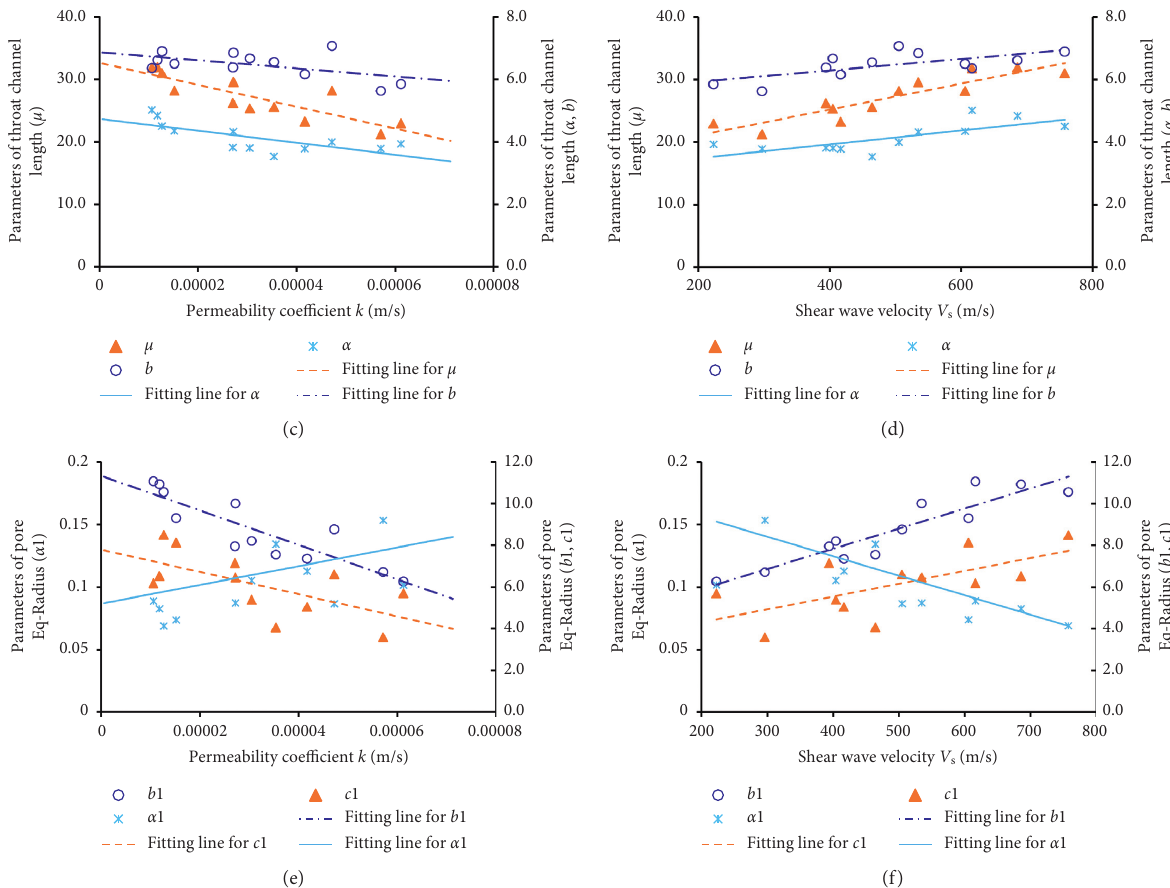
Figure 12: The relationships between the physical properties and the fitting function parameters of the loess: (a) permeability coefficient versus fitting function parameters of throat Eq-Radius; (b) shear wave velocity versus parameters of fitting function of throat Eq-Radius; (c) permeability coefficient versus coefficient of fitting function of throat channel length; (d) shear wave velocity versus fitting function coefficient of throat channel length; (e) permeability coefficient versus fitting function coefficient of throat of pore Eq-Radius; (f) shear wave velocity versus fitting function coefficient of pore